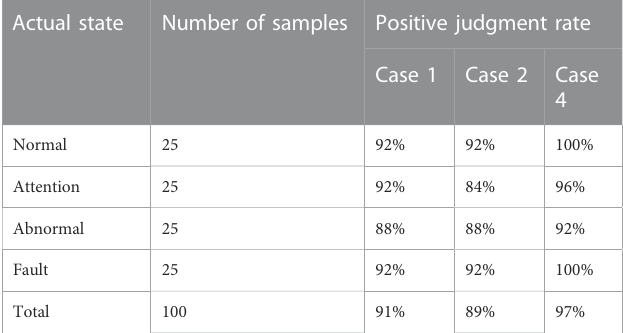
TABLE 7 Compare the positive judgment rates of different cases.